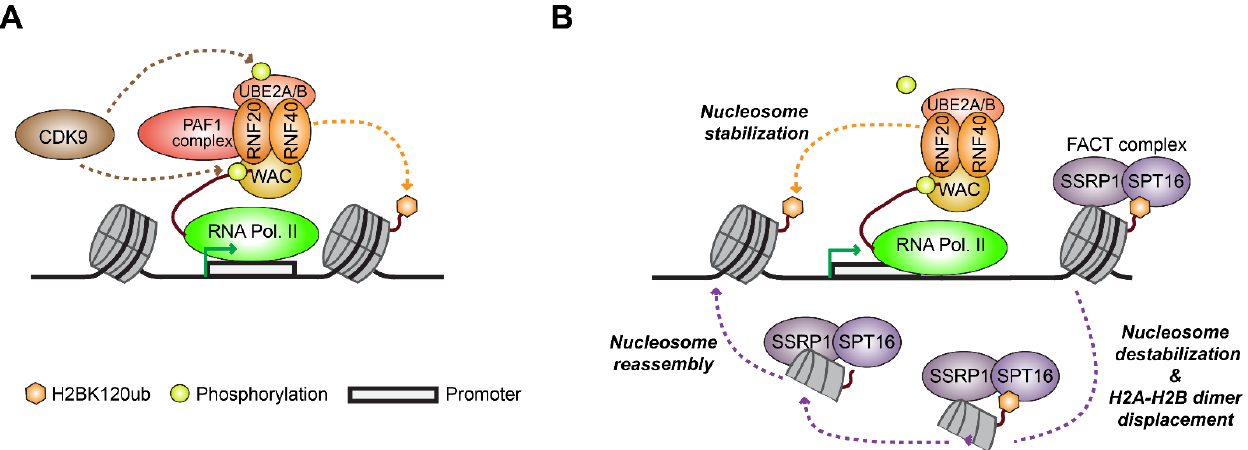
Figure 3. RNF20/40 and H2BK120ub facilitates transcriptional elongation. ( A ) To initiate H2B ubiquitination, RNF20/40, an E2 enzyme (UBE2A/B), and PAF1 create a complex that links to RNA polymerase II (Pol II) through WAC, following CDK9-dependent RNA Pol II phosphorylation. ( B ) H2BK120ub promotes FACT accumulation via interactions with the Spt16 subunit of FACT complex. In turn, the activity of FACT enables RNA Pol II transcriptional elongation by displacing the H2A/H2B dimer from the nucleosome. Subsequently, H2BK120ub and Spt16 also cooperate to promotes nucleosome reassembly and stabilization.